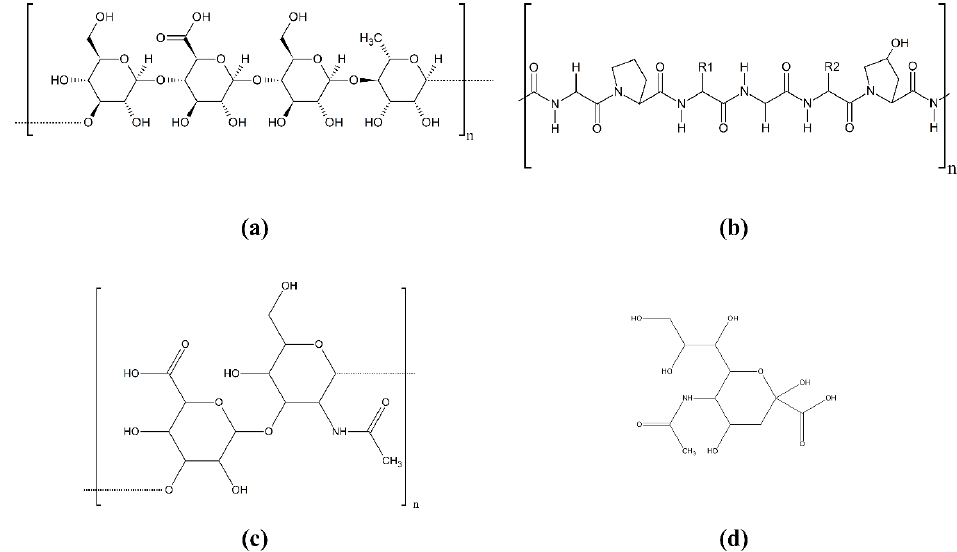
Figure 2. Chemical structures of GG ( a ), collagen type I ( b ), hyaluronic acid ( c ), and sialic acid ( d ).